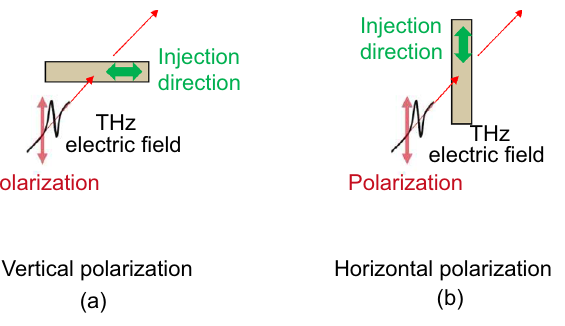
Figure 1. Schematic representation of the transmission measurement of composites reinforced with CNFs. ( a ) Vertical polarization; ( b ) horizontal